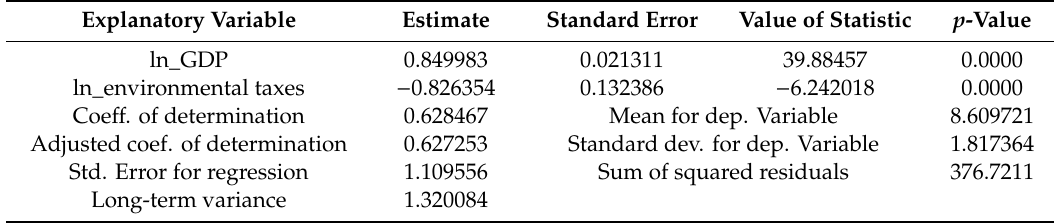
Table 8. Panel data model based on FMOLS estimators to explain changes in energy consumption from RESs in the EU countries and UK (2007–2019).